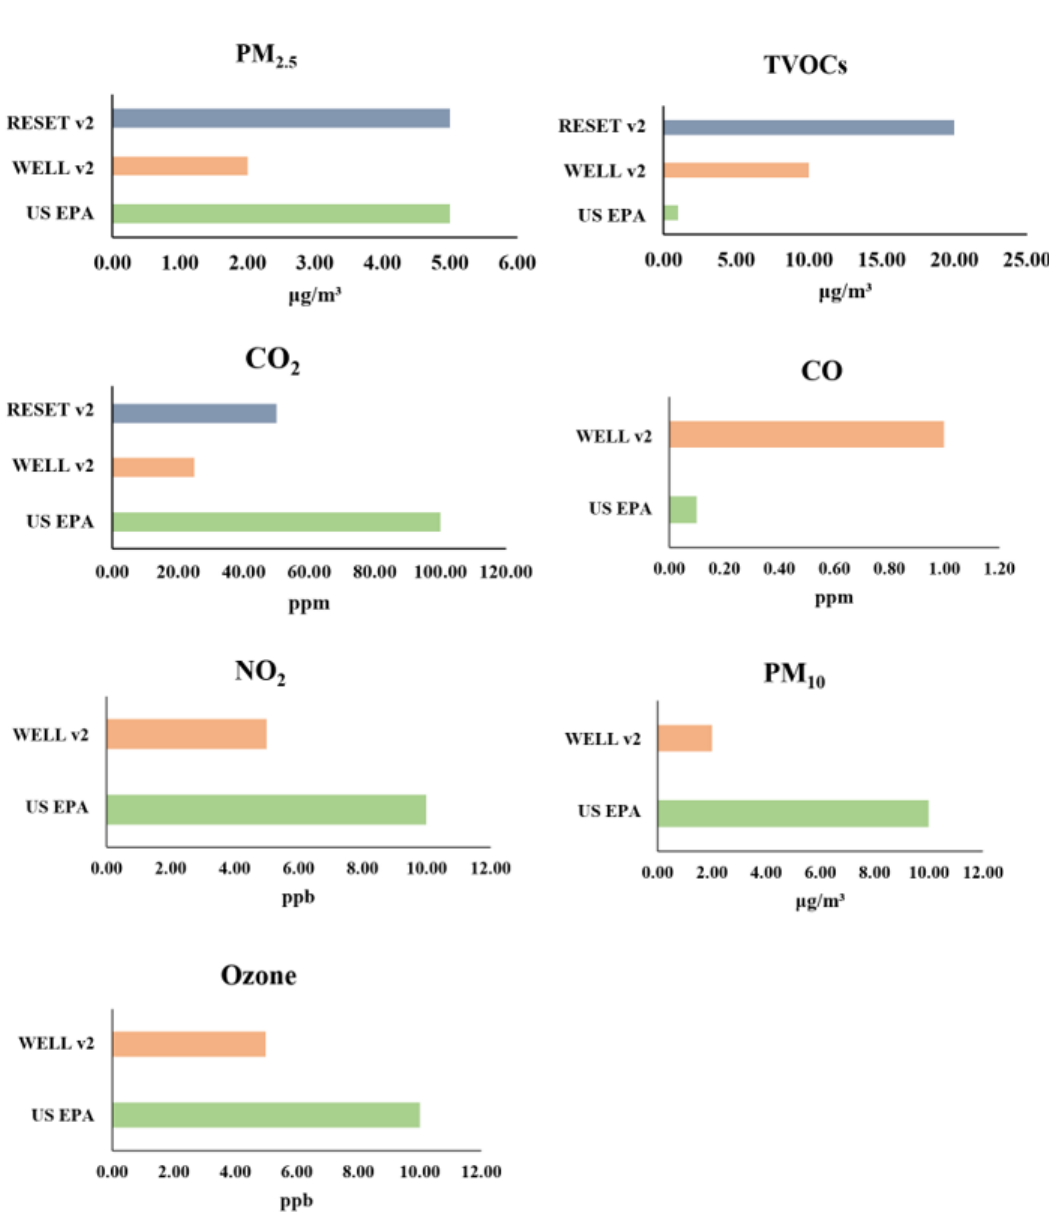
Figure 1. Comparison of the accuracy requirements of three standards on IAQ sensing technologies.